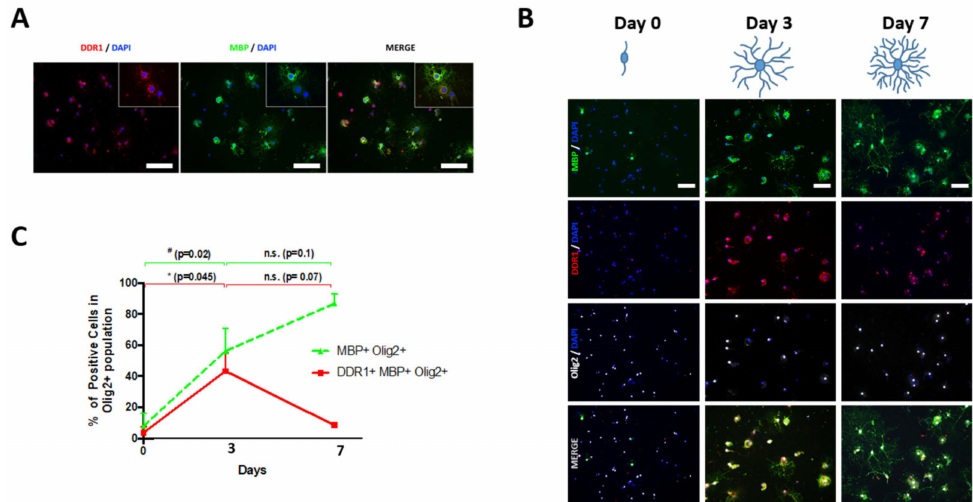
Figure 2. DDR1 is expressed during oligodendrogenic progression. Neural stem cells (NSCs) were obtained from the adult rat subventricular zone, expanded as neurospheres, and thereafter enzy- matically dissociated and plated as individual cells. After exposure to pericyte-conditioned culture medium (PC-CM), NSCs differentiated into mature OLs (day 7). ( A ) Fluorescence images displaying DDR1 (red) and MBP (green) and DDR1-MBP colocalization (merge panel) in NSCs after x days of exposure to PC-CM. DAPI was used for nuclear counterstaining (blue). Scale bar = 50 µ m. ( B ) Flu- orescence images displaying DDR1+, MBP+, and Olig2+ cells after 0, 3, and 7 days of incubation with PC-CM. DAPI was used for nuclear counterstaining (blue). Scale bar = 20 µ m. ( C ) Quantitative analysis showing MBP+ (green line) and DDR1+ and MBP+ (red line) cells among the total popu- lation of Olig2+ cells after 0, 3, and 7 days of exposure to PC-CM. The data show that the DDR1 levels peaked at day 3 and declined at day 7, whereas MBP expression continued to increase during oligodendrogenic progression. The data were obtained from three independent experiments and were analyzed by analysis of variance (ANOVA) followed by Tukey’s post hoc test. # and * p < 0.05, n.s.: not significant. * and # indicate significant differences between DDR1+ MBP+ cells and MBP+ cells, respectively, and the control